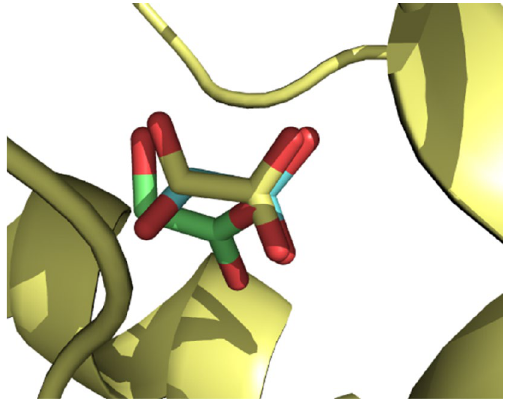
Figure 6. Glyoxylate conformation comparison between experimental ( yellow ), 2RDT docked ( green ), and 2RDopt ( turquoise ).